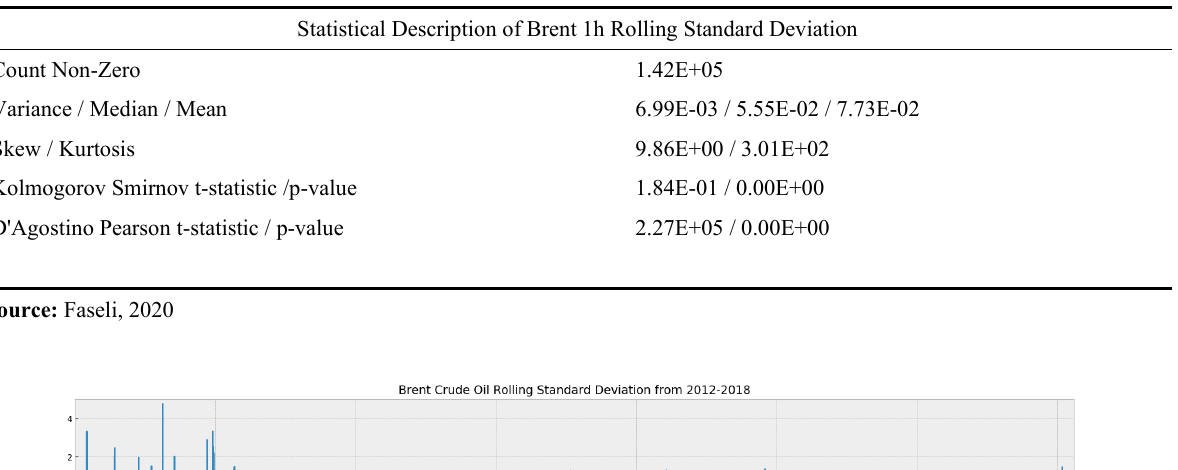
Table 1: Data statistics of a one hour window rolling standard deviation